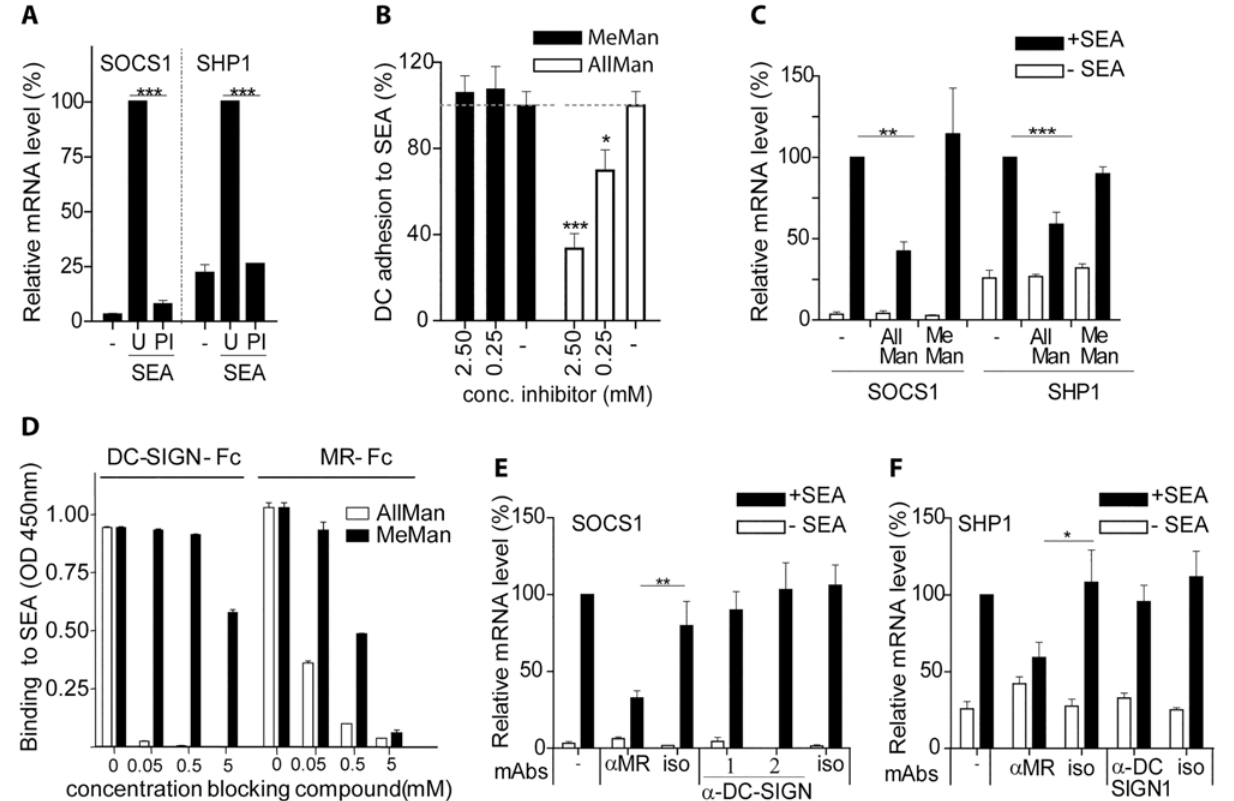
Fig 5. S . mansoni SEA induces SOCS1 and SHP1 in human dendritic cells (DCs) via the mannose receptor (MR). A . DCs were incubated with untreated (U) or periodate (PI) treated SEA (40 μ g/ml). After 4h, SOCS1 and SHP1 mRNA levels were determined by quantitative real-time PCR using GAPDH as a reference gene. B . Binding of DCs to SEA (coated at 5 μ g/ml) was determined in the presence or absence of different concentrations of the mannose derivates AllMan or MeMan. Binding of the DCs to SEA was set at 100% for each donor. C . DCs were pre-incubated for 2h with 2.5 mM of AllMan or MeMan, followed by incubation with SEA (40 μ g/ml) for 4h. Relative mRNA levels of SOCS1 and SHP1 were determined by quantitative real time PCR using GAPDH as a reference gene. D . Inhibition of DC-SIGN-Fc and MR-Fc binding to SEA (coated at 5 μ g/ml) was detected in the presence of low concentrations of AllMan (0.5 – 5 mM). E-F . DCs were pre-incubated for 2h with anti-MR, anti-DC-SIGN1 or anti-DC-SIGN2 mAbs (5 μ g/ml), or their respective isotype control mAbs, followed by incubation with SEA (40 μ g/ml) for 4h. Relative mRNA levels of SOCS1 ( E ) and SHP1 ( F ) were determined by quantitative real time PCR using GAPDH as a reference gene. All data shown are derived from experiments performed in duplicate using DCs of 4 (A, C), 3 (B) or 5 (E, F) different donors. Results are shown as the mean plus or minus SEM. In A , C , E and F , DCs incubated with untreated SEA were set at 100%. Significance is indicated compared to DCs stimulated with untreated SEA as * p < 0.05, ** p < 0.01 and *** p <